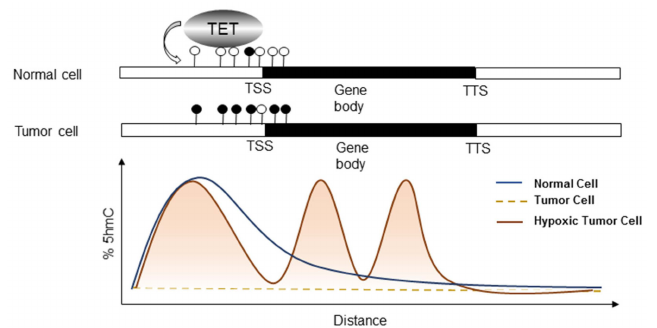
Figure 4. Methylation status and 5hmC levels in normal, tumor, and hypoxic tumor cells. In normal cells, particularly in ES and hematopoietic cells, TET proteins are highly abundant, usually in accordance with an enrichment in 5hmC and unmethylated DNA (white circle). However, during tumorigenesis, many of the CpG islands near or around the promoters of tumor suppressors are highly methylated (dark circle). Loss of 5hmC and TET proteins can be detected globally or site-specifically. However, when tumor cells undergo hypoxia, TET proteins can be induced by HIF-1 α and elevated 5hmC composition can be detected at promoters, introns, exons, as well as 3 1 -UTR at a global scale (76), leading to gene expressions, e.g., those in the EMT and metabolic pathways. Hypoxic tumor